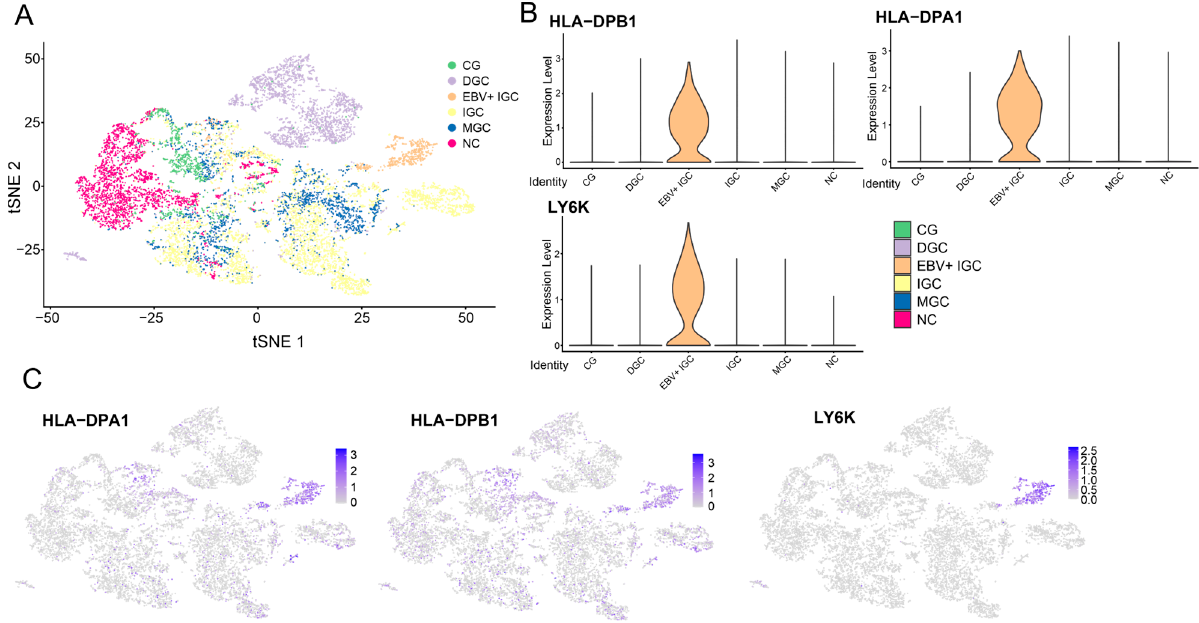
Figure 5. Single-cell analysis data for all epithelial cells grouped by histopathological type. ( A ) Dimensional reduction plot (tSNE) of all epithelial cells, both malignant and healthy. ( B ) Violin plots showing the expression levels of 3 different GOIs ( HLA-DPA1 , HLA-DPB1 , LY6K ). ( C ) Feature plot (tSNE) showing relative expression levels of 3 different GOIs ( HLA-DPA1 , HLA-DPB1 , LY6K ).